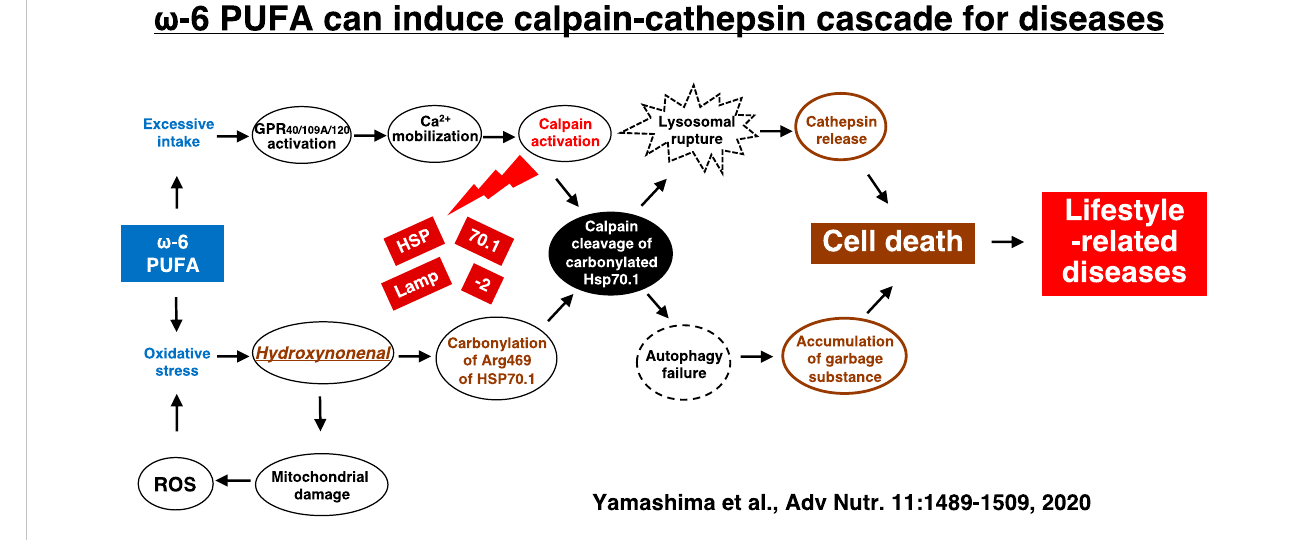
The calpain-cathepsin cascade explaining the molecular mechanism from ω -6 fatty acid-rich PUFA to cell death in lifestyle-related diseases. Diverse G protein-coupled receptors as GPR40/109A/120 in the brain/pancreas/liver are related to Ca 2+ mobilization in response to fatty acids. Simultaneously, circumferential oxidative stress and/or deep frying may cause oxidation of ω -6fatty acid with theresultant generation of hydroxynonenal.Hsp70.1 isastress- induced protein or lysosomal stabilizer that confer cell protection against diverse stimuli, but its dysfunction caused by calpain-mediated cleavage of carbonylated Hsp70.1 induces diverse cell degeneration via lysosomal rupture and autophagy failure. It is probable that the same disorder may occur for the other lysosomal membrane proteins like Lamp-2. Adapted with permission from Yamashima et al.